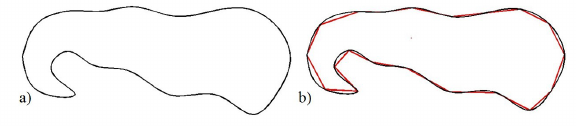
Figure 1: Embankment construction: a) on the base, which is a set of any shoreline, b) through a closed broken closed (closed chain of sections) (Koźniewski et al., 2013)